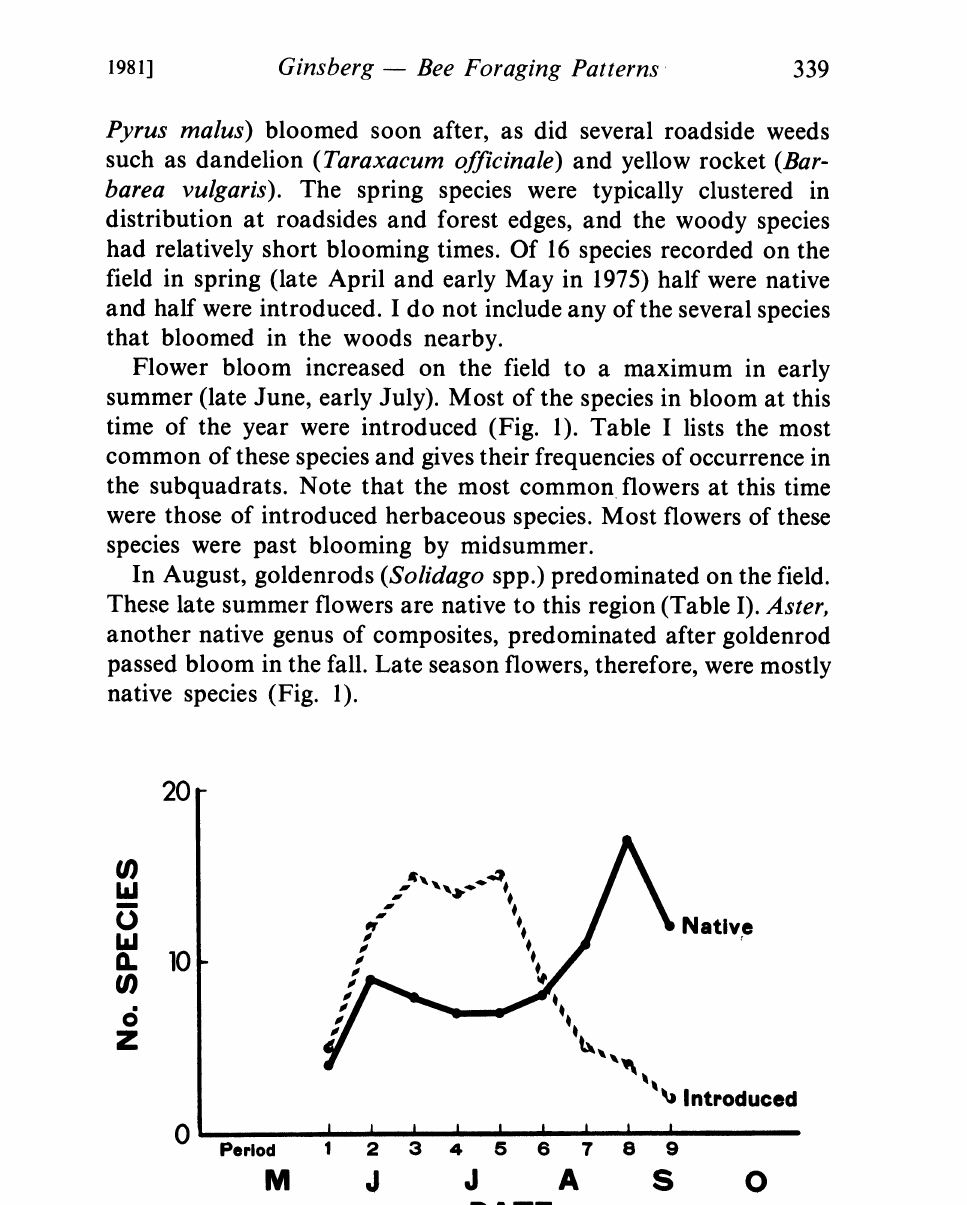
Fig. 1. Number of introduced and native flower species blooming over the summer, 1974, in an old field near Ithaca, New